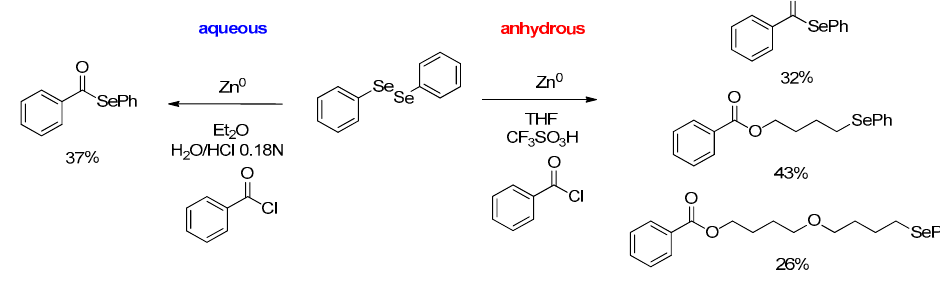
Figure 5. Chemoselectivity in aqueous conditions.